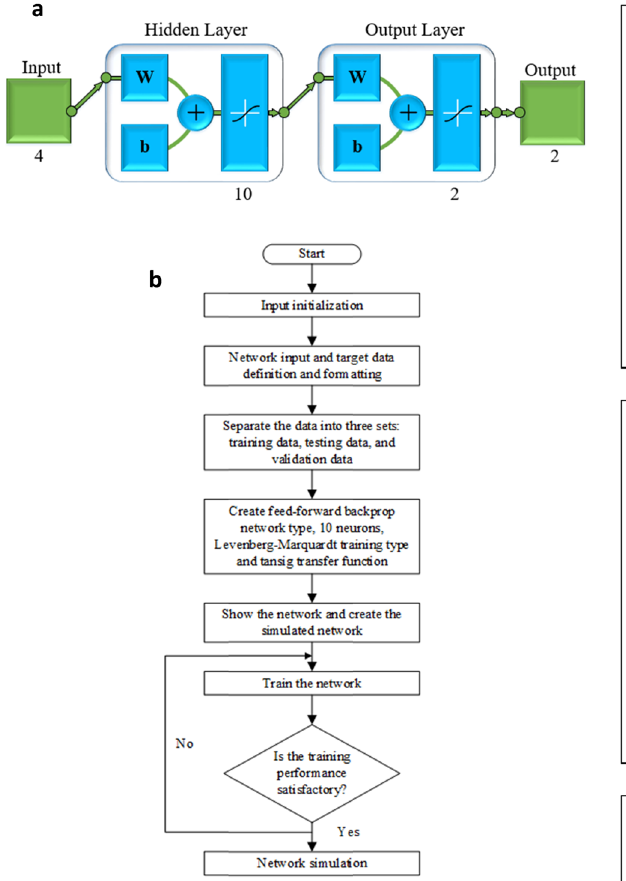
Figure 4: ( a ) ANN model. ( b ) Flowchart of neural network algorithm for determining cutting force and surface roughness.